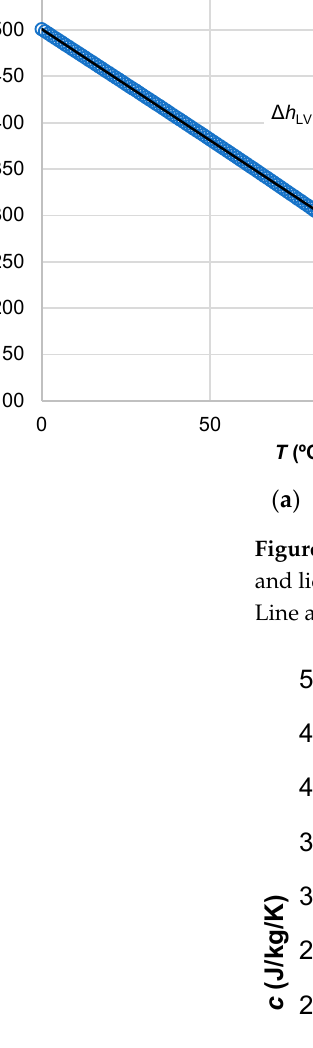
fálová and Šafa ř ík [24].